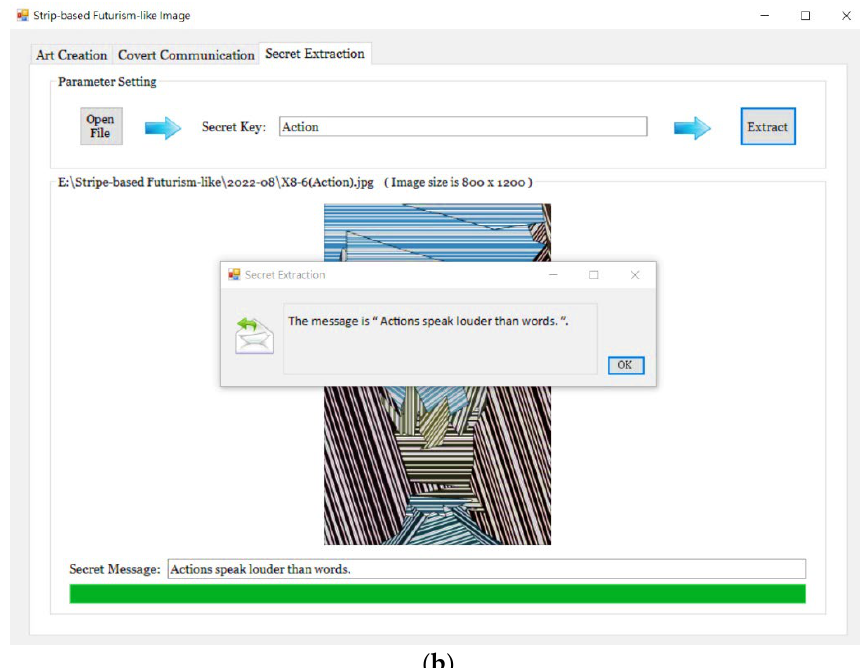
Figure 19. A second illustration of extracting the secret message from the stego-image using the right secret key. ( a ) The stego-image with the stripe widths of 6 pixels shown in Figure 15e. ( b ) The correct result “Actions speak louder than words.” of hidden data extraction using the secret key “Action”.